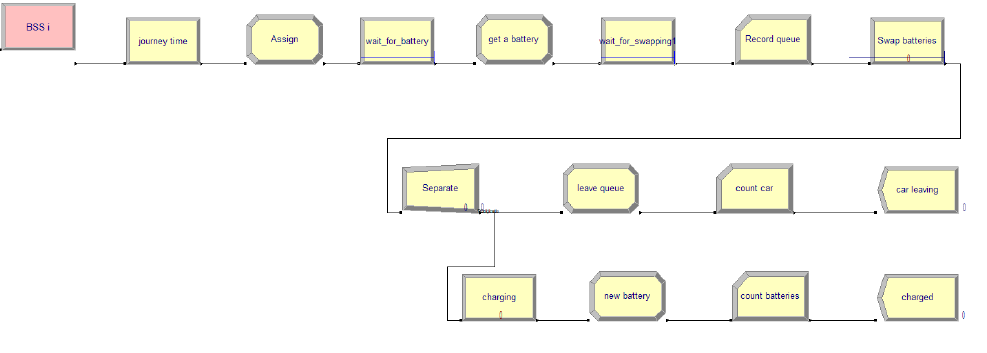
Figure 15. Battery swapping process.